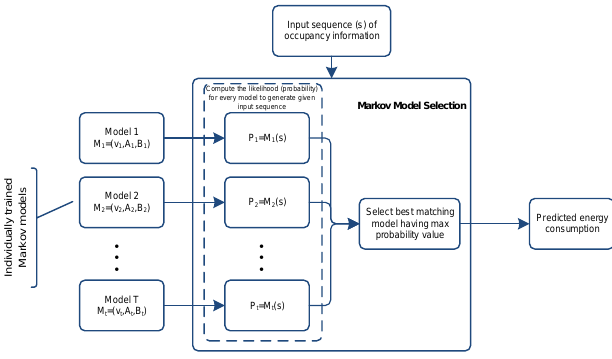
Figure 4. Energy prediction from observed occupancy data using Hidden Markov